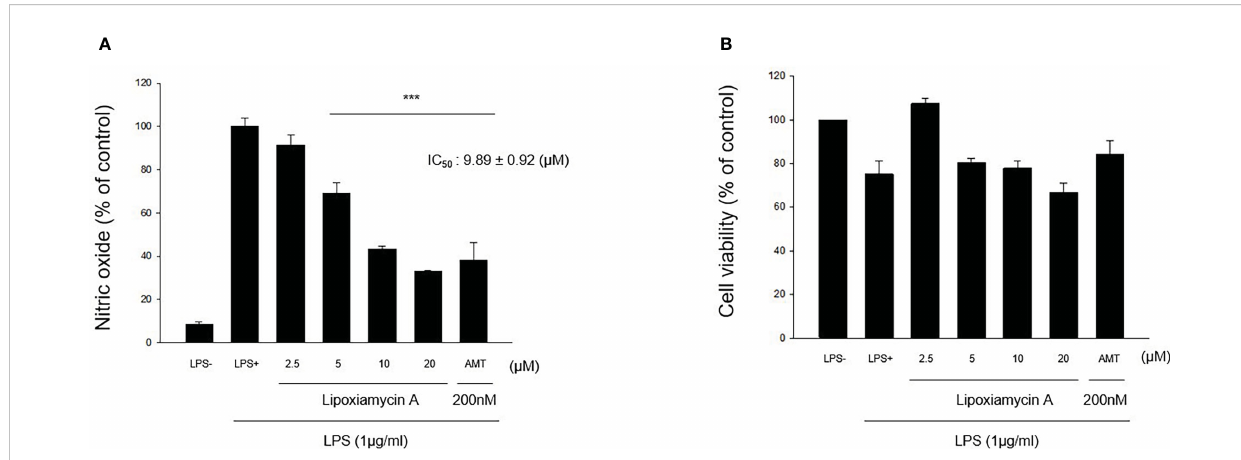
FIGURE 7 Effect of lipoxiamycin A (1) on LPS-stimulated NO production in macrophage cells. (A) RAW 264.7 cells were pre-treated with lipoxiamycin A (2.5, 5, 10, and 20 µM) for 1 h and then stimulated with LPS (1 µg/mL) for 20 (h) The supernatant from each well was collected to determine the degree of